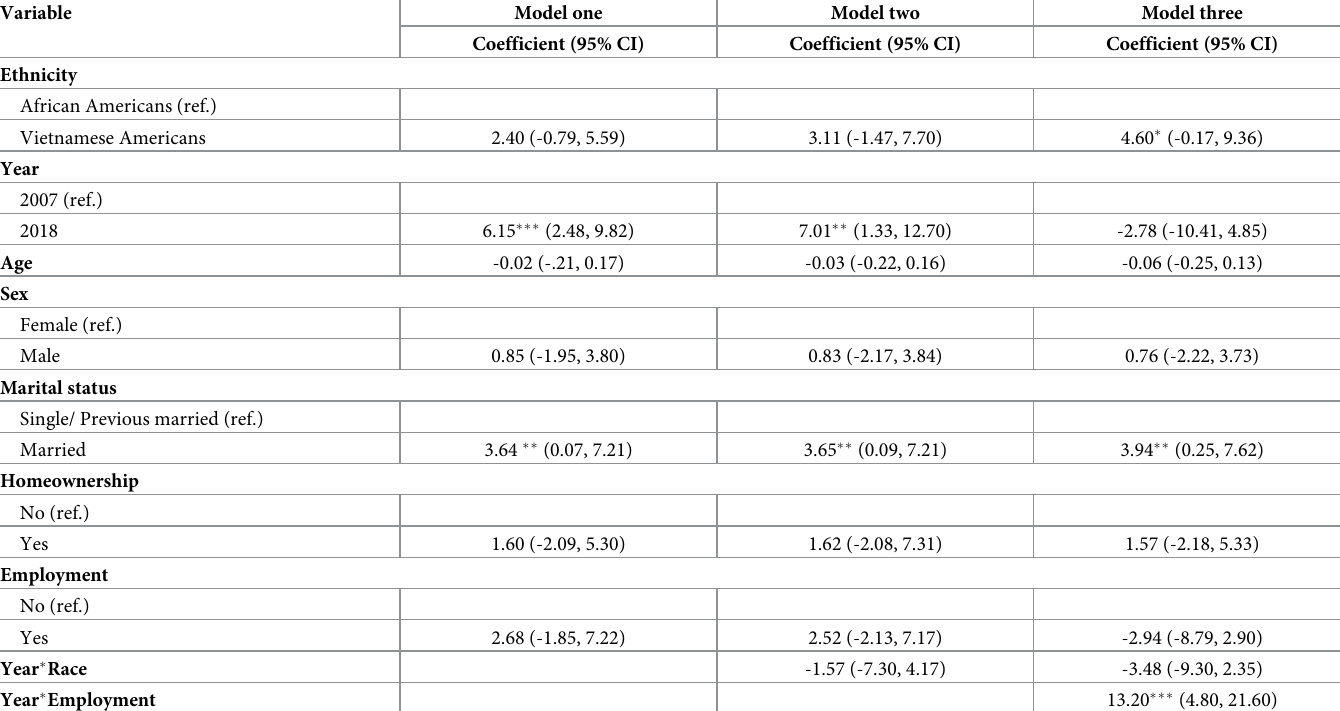
Table 3. Differences of post-disaster mental health between African American and Vietnamese American participants using a combined 2007 and 2018 dataset (N = 253), applying generalized estimating equations